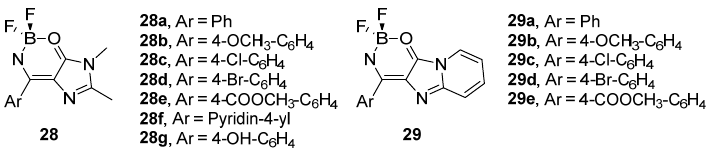
Figure 27. GFPc analogues with a boron complex blocking the Z/E isomerization [45].